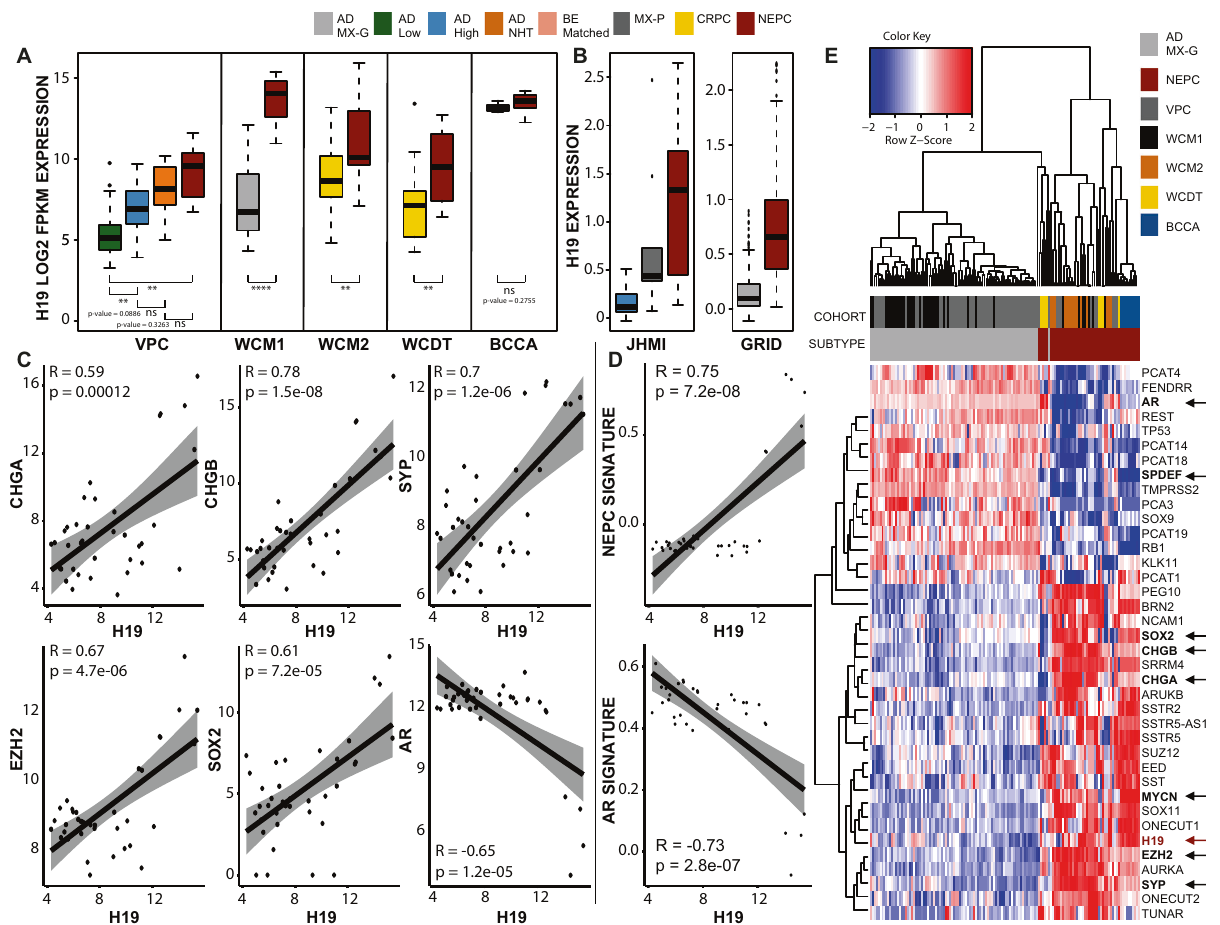
Fig. 1 H19 expression across clinical NEPC cohorts. A Sequenced NEPC clinical cohorts. In the VPC cohort ( n = 75), rising levels of H19 expression are seen across increasing Gleason grades (Gleason grading ≦ 6 = AD Low and Gleason grading ≧ 8 = AD High), including NHT treated samples and peaks in NEPC. Signi fi cant upregulation of H19 is observed in mixed Gleason grading (MX-G) adenocarcinoma vs. NEPC in the WCM1 cohort ( n = 37) and CRPC vs. NEPC samples of WCM2 ( n = 49) and WCDT ( n = 45) cohorts. Non-signi fi cant (ns) yet the elevated expression of H19 is observed in benign (BE) vs. dNEPC of the BCCA cohort ( n = 15), yet possibly due to high tumor cellularity in matched BE samples. B Microarray NEPC clinical cohorts. Similarly, in the JHMI ( n = 33) and GRID ( n = 526) cohorts, rising levels of H19 from AD High/AD MX-G to mixed AD and small cell pathology (MX-P) to NEPC are observed. Box and Whisker plots display lower quartile, upper quartile, and median bounds of cohort expression at the box ’ s minima, maxima, and centerlines, respectively. Whisker lines display lower (bottom) and upper (top) extreme value ranges. Single data points represent outliers in a cohort. p Values were calculated by an unpaired two-sided Student ’ s t test. Signi fi cance was represented by * p < 0.05; ** p < 0.01; *** p < 0.001 and **** p < 0.0001 unless speci fi cally noted. C In WCM1, H19 shows a signi fi cant positive correlation with CHGA/B, SYP, SOX2, and EZH2 and shows a signi fi cant negative correlation with AR expression. D Again in WCM1, H19 shows a signi fi cant positive and negative correlation to known NEPC and AR gene signatures, respectively. Correlation coef fi cients ( R ) and p values ( p ) were calculated using a Pearson correlation statistical test. The shaded area represents con fi dence intervals at 95%. E Unsupervised hierarchical clustering of 38 known genes/lncRNAs in our NEPC ( n = 50) and AD MX-G ( n = 86) samples merged across all cohorts show a clear strati fi cation of these two phenotypes. Select genes denoted by arrows have been shown in our correlation analysis from panel C and Supplementary Fig. 4A – driving the expression of this lncRNA. A sensitive bisul fi te-free organoids OWCM-154, -155, -1078, and -1262 37 . H19 expression assay (Methylmeter 38 ) was used to measure the methylation levels was markedly elevated in 3 of the 4 NEPC organoids compared to on the CpG site of ICR1 (Supplementary Methods). Endogen- organoids derived from normal prostate or PCa patients who ously the 1624bp MseI fragment containing the imprinting center underwent primary tumor resection for AdPC (Fig. 3A). These CTCF binding regions (1 – 3) is methylated on the paternal copy. samples also exhibited increases in stem cell and NE markers in To evaluate DNA methylation changes in NEPC, DNA from cell NEPC vs. non-NEPC samples (Supplementary Fig. 8A). In lines and controls were cleaved with MseI, and the number of addition, the NEPC cell lines, NCI-H660 and LASPC-01, com- methylated versus unmethylated DNA copies in the two fractions pared to AdPC cell lines C4-2B, VCaP, and LNCaP, express were calculated (Supplementary Fig. 8D). The methylation elevated H19 , stem cell genes, and NE markers (Fig. 3B, Sup- percentage was quanti fi ed by coupled abscription PCR signaling plementary Fig. 8B). Similarly, H19 is elevated in the tNEPC (CAPS) (Supplementary Methods, Supplementary Fig. 6D). model cell lines 42D ENZR and 42F ENZR compared to the CRPC cell line V16D CPRC (Supplementary Fig. 8C). Results indicate that the AdPC cells (LNCaP, C4-2B, and The methylation status of the H19/IGF2 imprinting control V16D) have a higher percent of ICR1 methylation when region (ICR1, Supplemental Figs. S8D and S11B) is critical in compared to the NEPC cell line (NCI-H660) and NEPC organoid